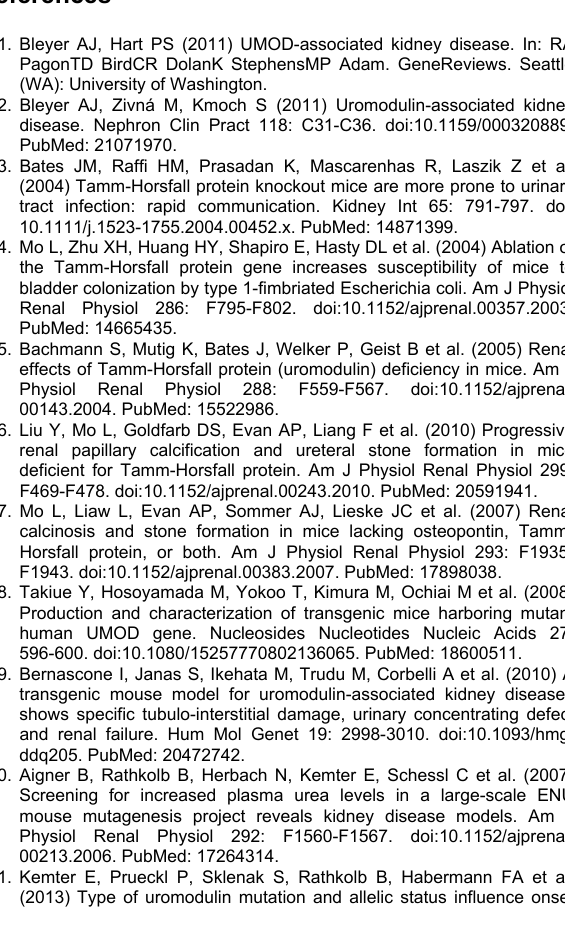
Table S1. Time points of the phenotypic analyses described for the lines Umod A227T and Umod C93F in the German Mouse Clinic